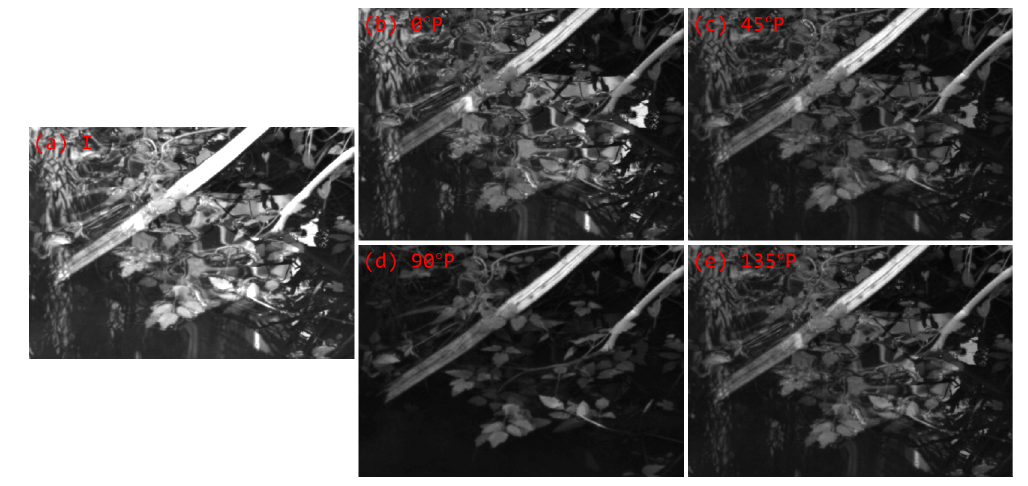
Figure 3. Case Ⅱ : phytoplankton